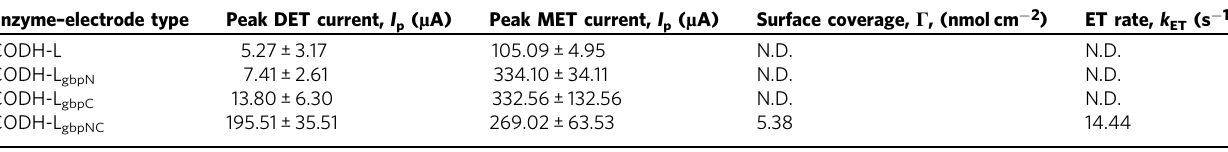
Table 3 Peak currents, I p , observed for the DET and MET conditions. Enzyme – electrode